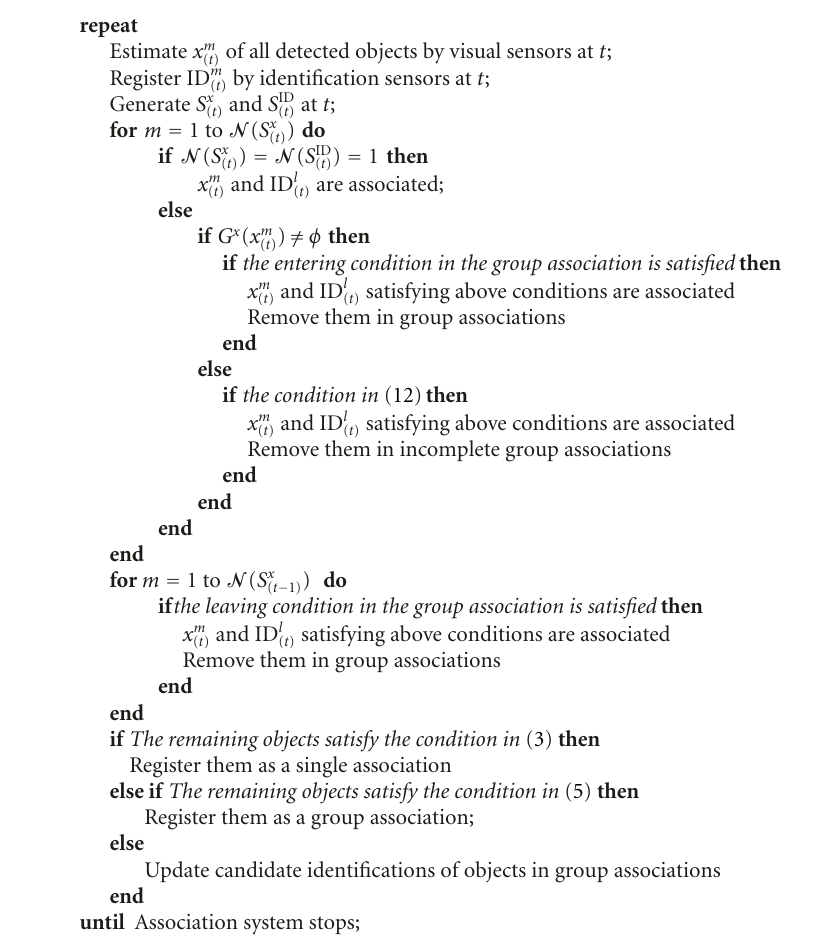
Algorithm 1: The proposed association